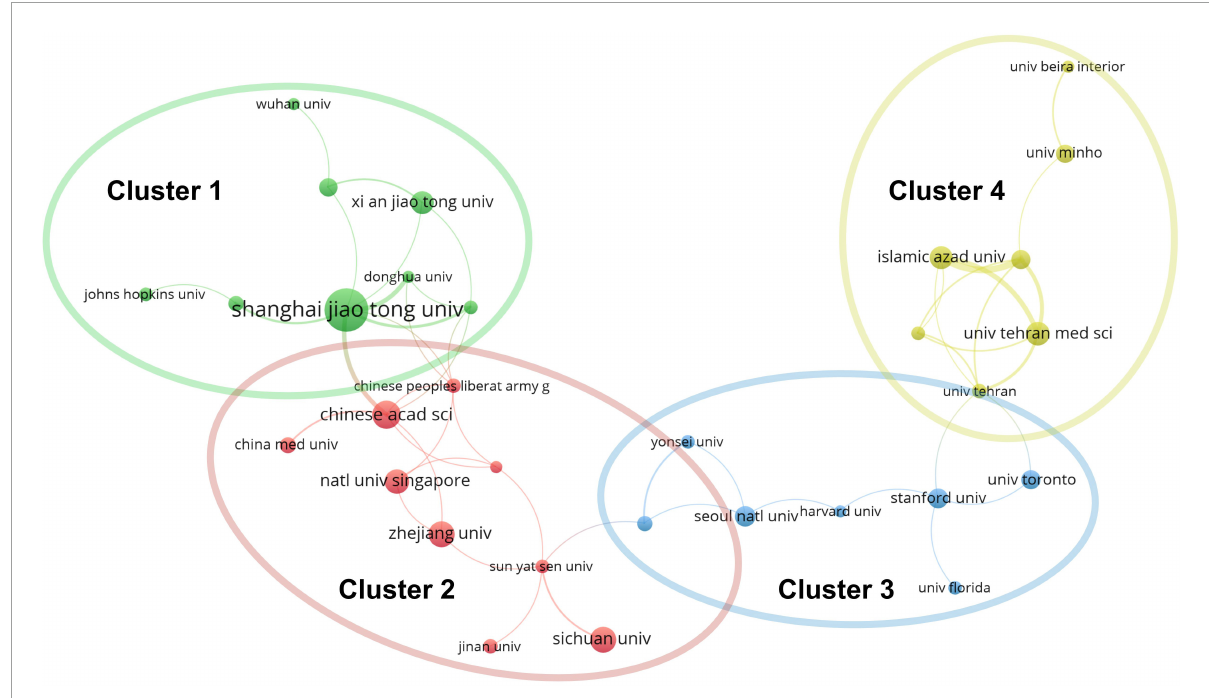
FIGURE4 Co-authorship analysis of organizations divided into five clusters, indicated with different colors. The large icon indicates organizations with high frequencies. Maximum number of countries per paper: 25; minimum number of countries per paper: 10; and minimum number of citations from one country: